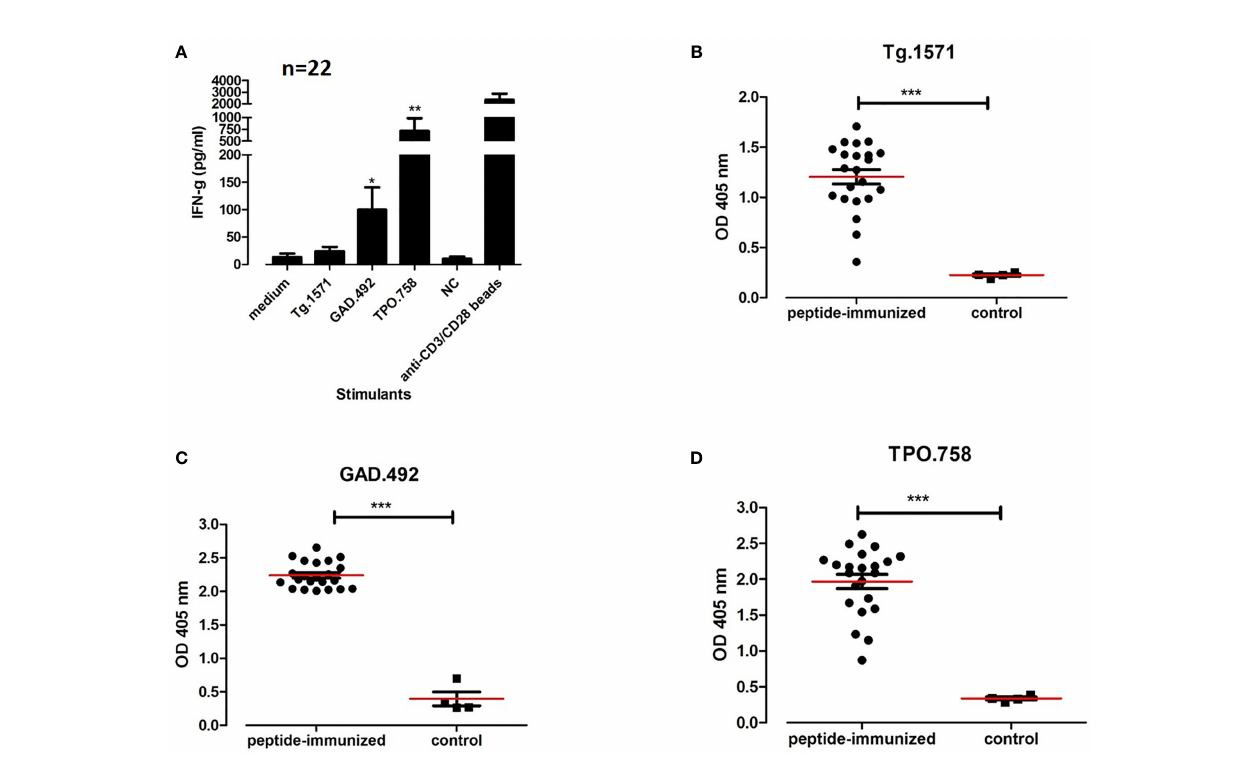
FIGURE 6 | Twenty-two humanized NOD-DR3 mice were co-immunized with Tg.1571, GAD.492 and TPO.758. Supernatant from stimulated splenocytes were collected and assayed for cytokine production. Sera were also collected for autoantibody measurements. Figure 6 shows interferon gamma production (A) and autoantibody response to Tg.1571 (B) , GAD.492 (C) and TPO.758 (D) of humanized NOD-DR3 mice co-immunized with the three thyroid and islet peptides. NC, negative control peptide. Anti-CD3/CD28 beads, positive control. Control mice were immunized with PBS and adjuvant. * p < 0.05; ** p < 0.01; *** p < 0.001.